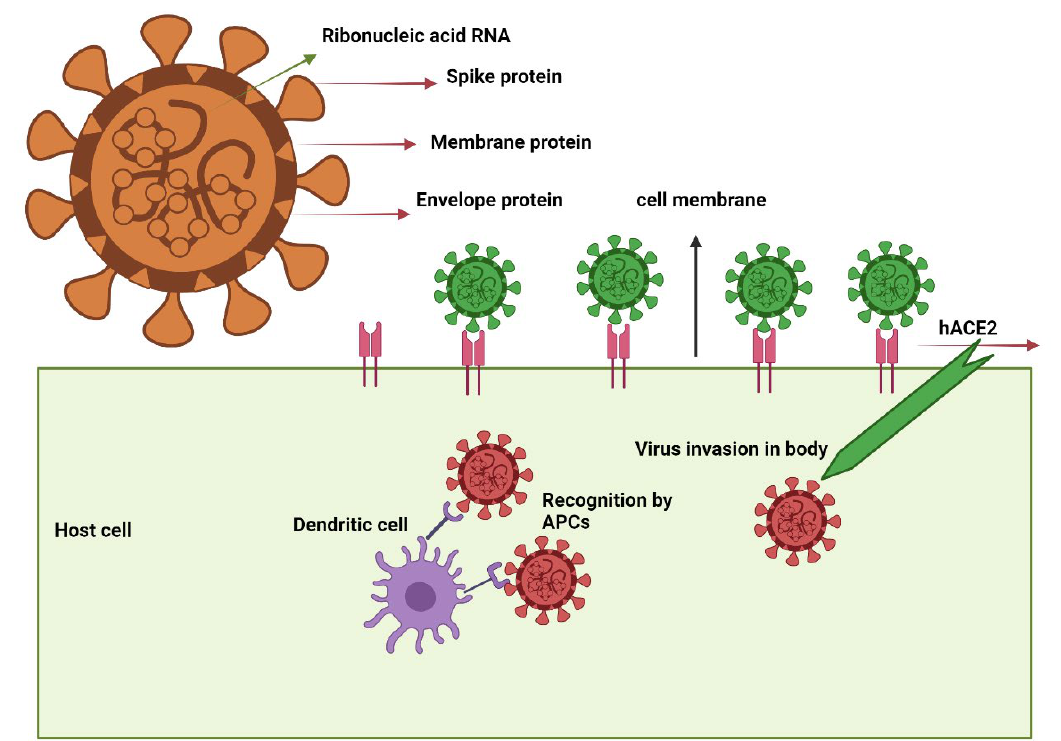
Figure 1. SARS-CoV-2 virus schematic illustration showing the target proteins and mechanism of entry into the host cell. SARS- CoV-2 virus structural proteins include S, M, and E protein. When SARS-CoV-2 enters host cells, it is recognized by the hACE2 and processed by APCs, particularly dendritic cells, which initiate the signaling cascade